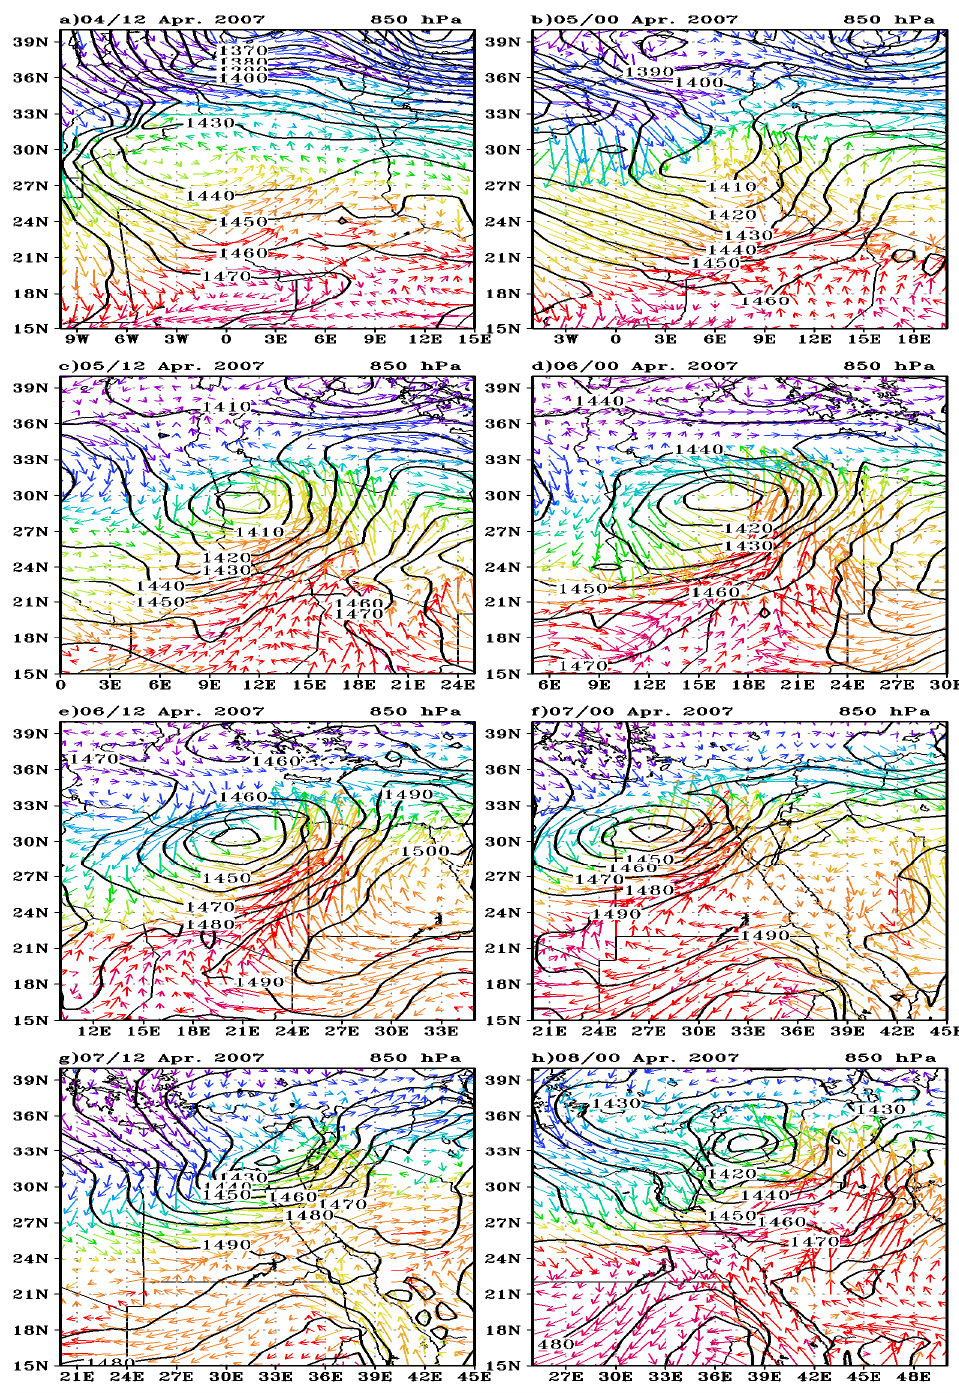
Figure 3. The 850 hPa geopotential height contour at every 10 gpm interval (solid) and wind in vectors (m/s) at 12Z and 00Z for 4–8 April 2007. The main synoptic feature at 12Z04 April 2007 was an anticyclone centered over west ‐ ern Europe extending easterly at the surface to the southwest of Europe and north ‐ west Europe. A cyclone appeared as a trough in the upper layers of the atmosphere over